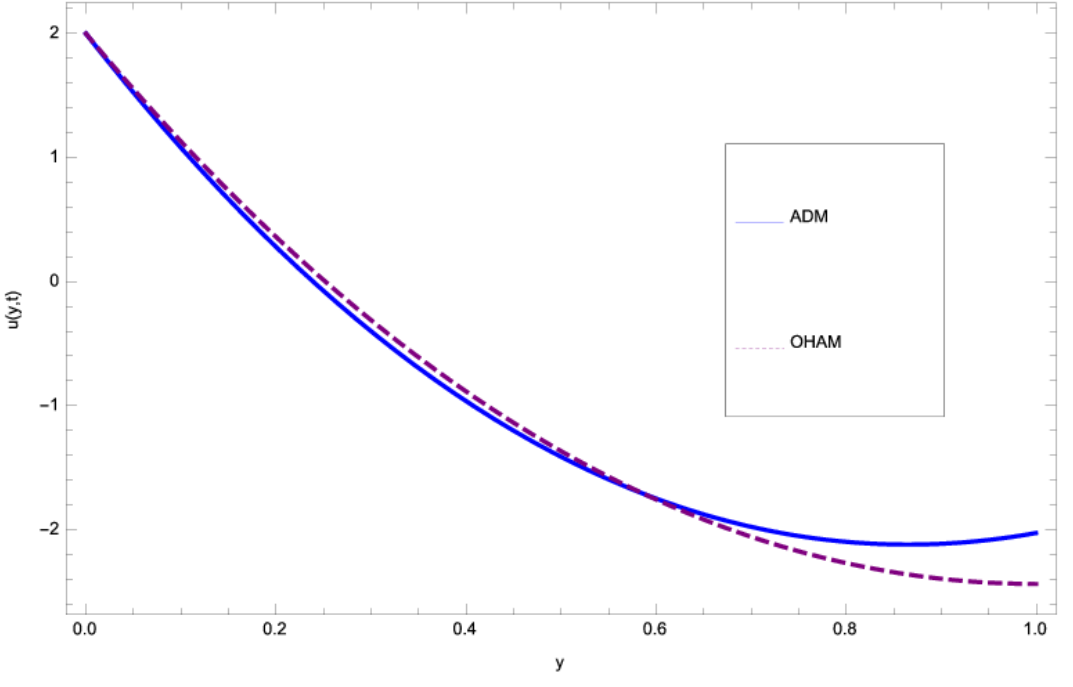
Figure 14. The comparison of Adomian Decomposition Method (ADM) and Optimal Homotopy Asymptotic Method (OHAM) methods for the velocity profile, when W e = 0.01, m = 8.3; M = 0.01, ω = 0.02, t = 1.6,C 1 = 1.3196149901566254,C 2 = −